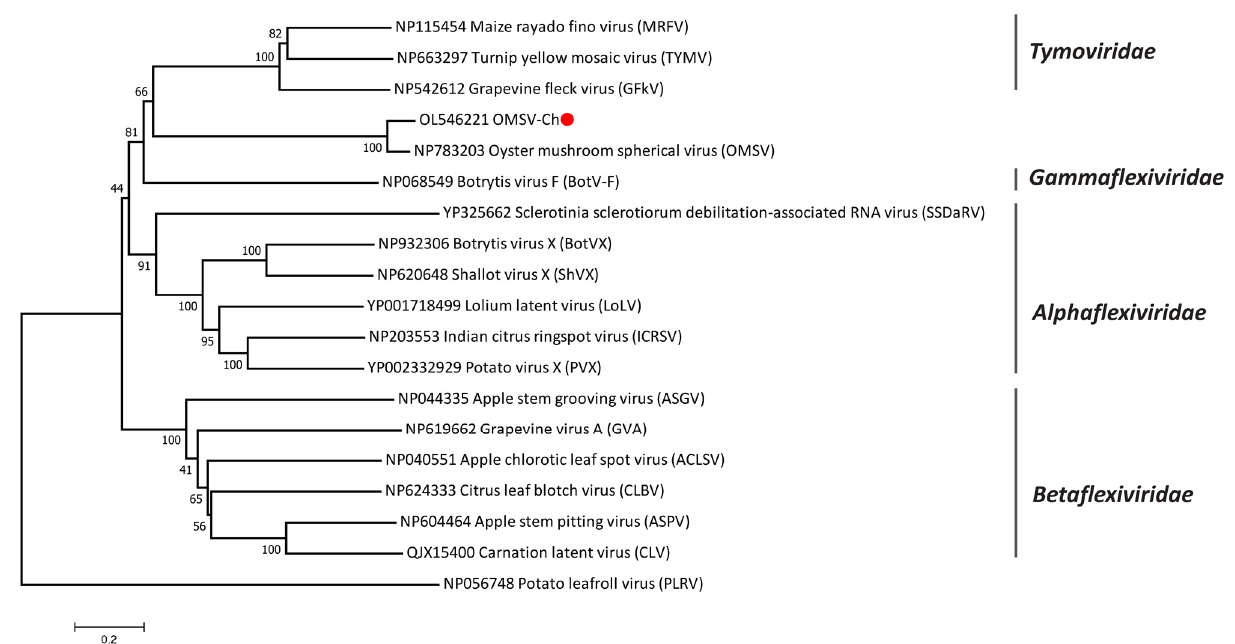
Figure 2. Phylogenetic tree based on the amino acid sequences of the replication protein of OMSV-Ch and 17 representatives of the order Tymovirales . The OMSV-Ch sequence from the present study is marked with a red dot. Potato leafroll virus (PLRV) was used as an outgroup.